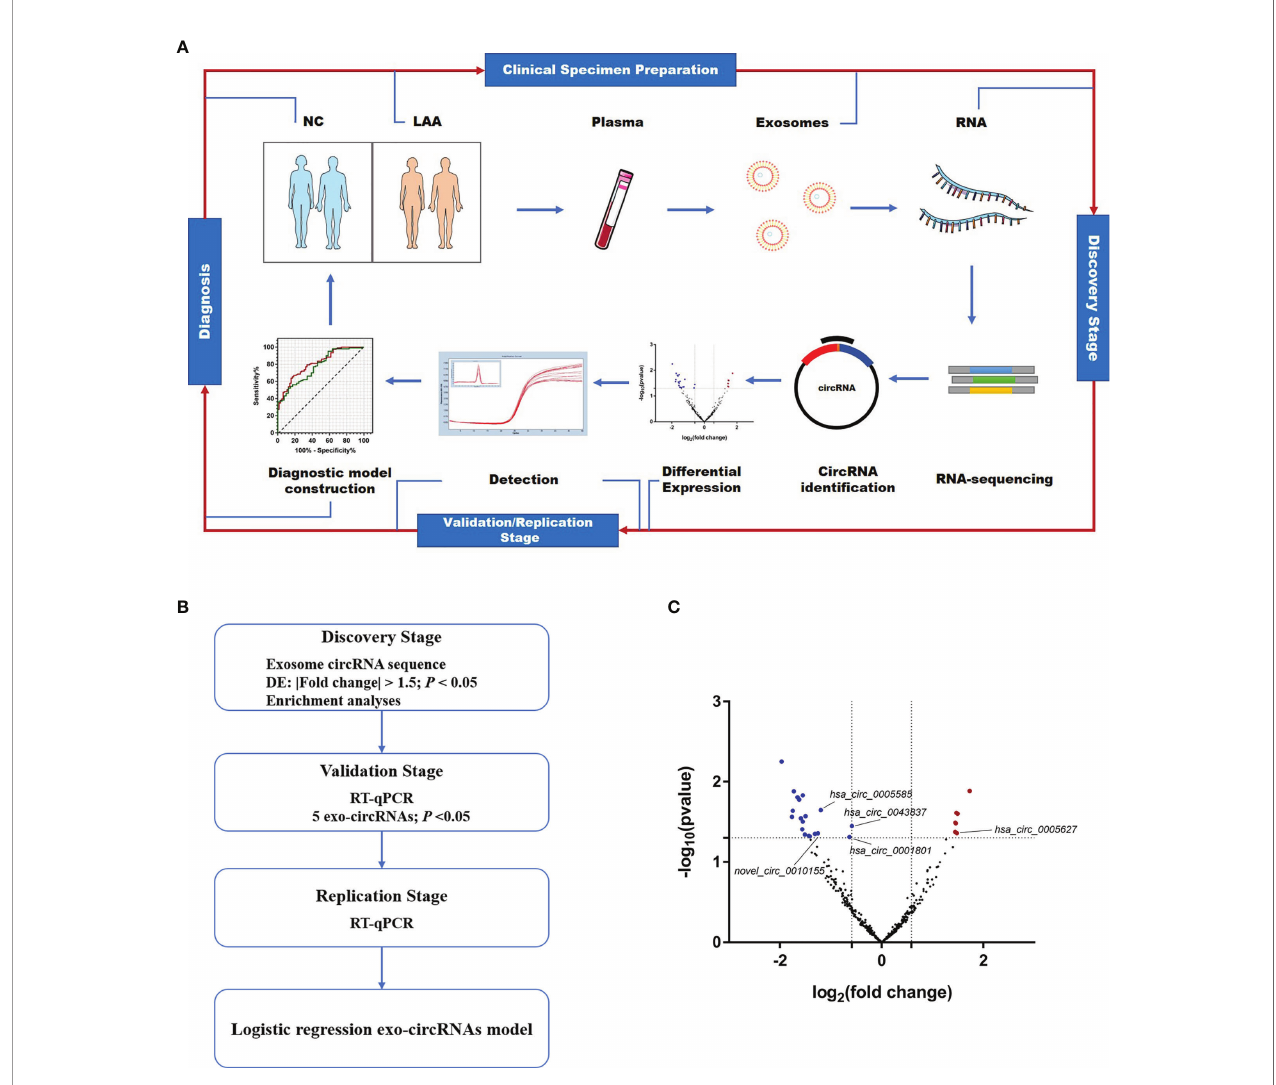
FIGURE 1 | Expression pro fi les of circulating exosome-circRNAs. (A) Work fl ow of the study, including clinical samples preparation, discovery stage of circRNA sequencing, detection and diagnosis. (B) Work fl ow of the discovery, validation and replication stage of circulating exo-circRNAs. (C) Volcano map of circRNAs in exosome RNA-seq, with red showing up-regulated expression in the LAA group and blue showing